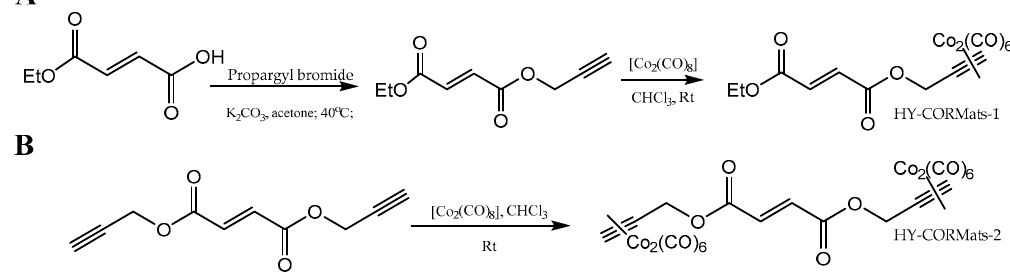
Figure 18. Synthesis route of hybrid CORMats: ( A ) HY ‐ CORMats ‐ 1; ( B ) HY ‐ CORMats ‐ 2.